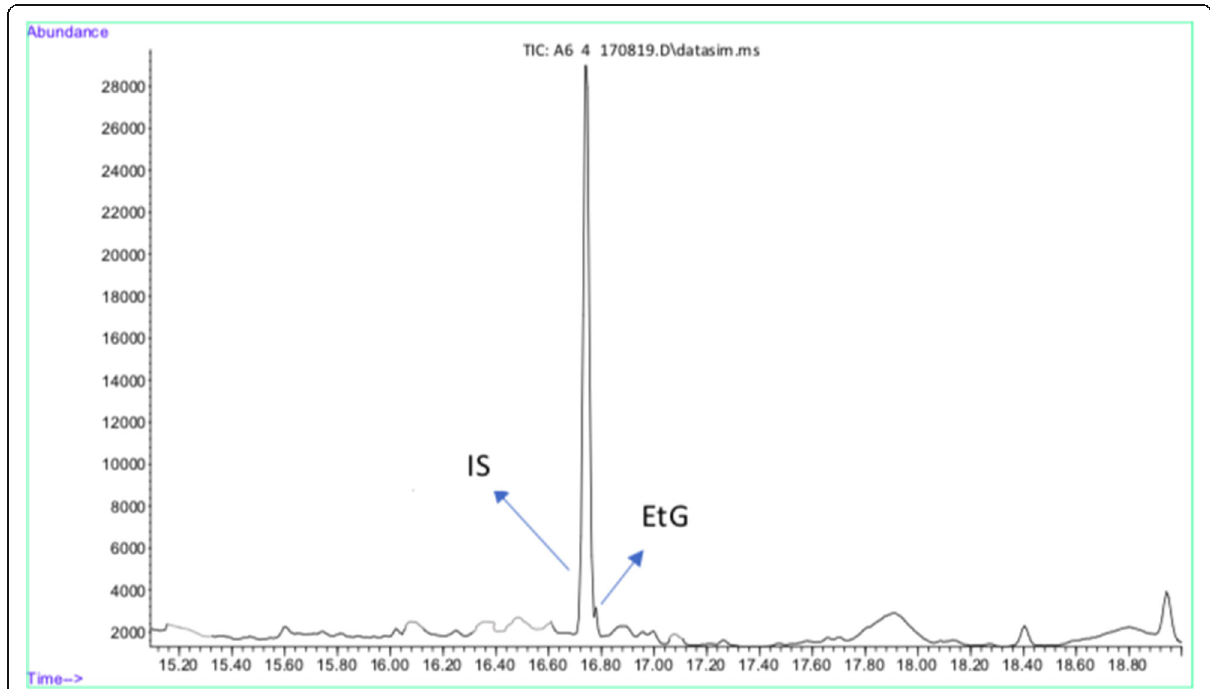
Fig. 6 Chromatogram of a patient ’ s urine showing presence of EtG (45 ng/ml)